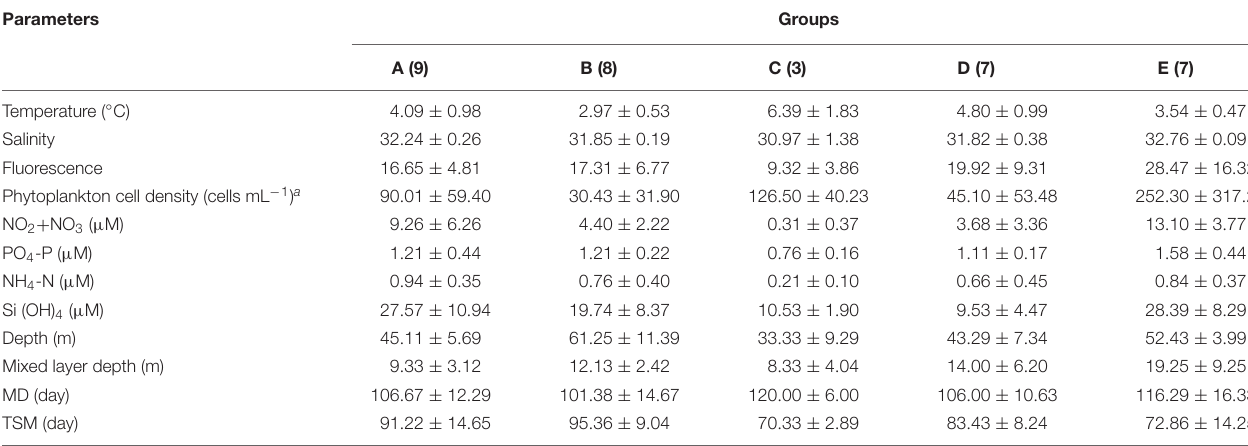
TABLE 3 | Mean and standard deviations of environmental factors between the groups identified by cluster analysis (cf. Figure 4 ) in the northern Bering Sea during July of 2017 and 2018.